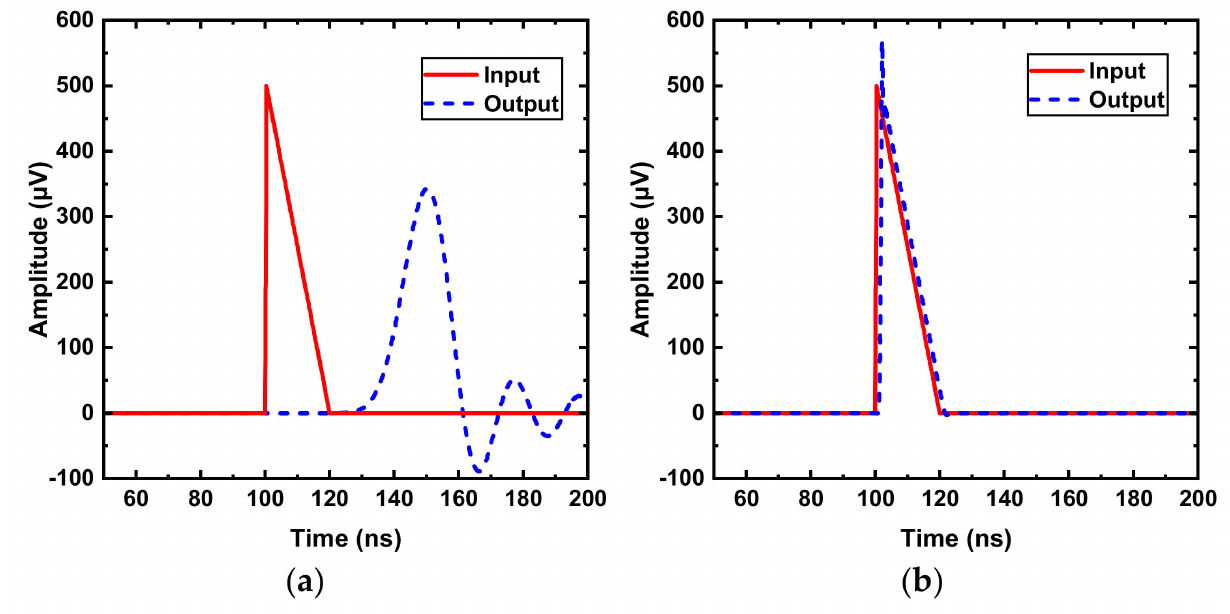
Figure 4. Transient response of the signal with different bandwidths: ( a ) Bandwidth = 100 MHz; ( b ) Bandwidth = 1